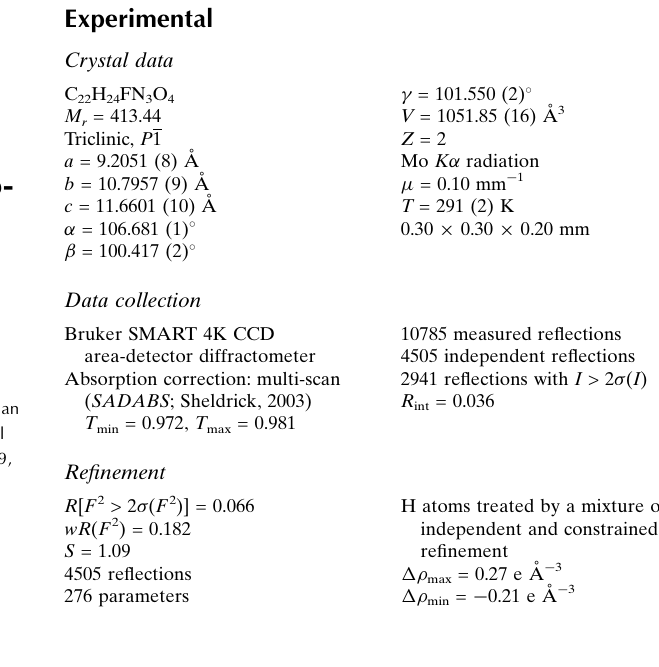
Hydrogen-bond and C—F (cid:2)(cid:2)(cid:2) (cid:2) and C—O (cid:2)(cid:2)(cid:2) (cid:2) interactions (A˚ , (cid:1) ). Cg 2 and Cg 3 are the centroids of the N1/C9/C7/C8/N2/C10 and C11–C16 rings, respectively. D —H (cid:2)(cid:2)(cid:2) A D —H H (cid:2)(cid:2)(cid:2) A